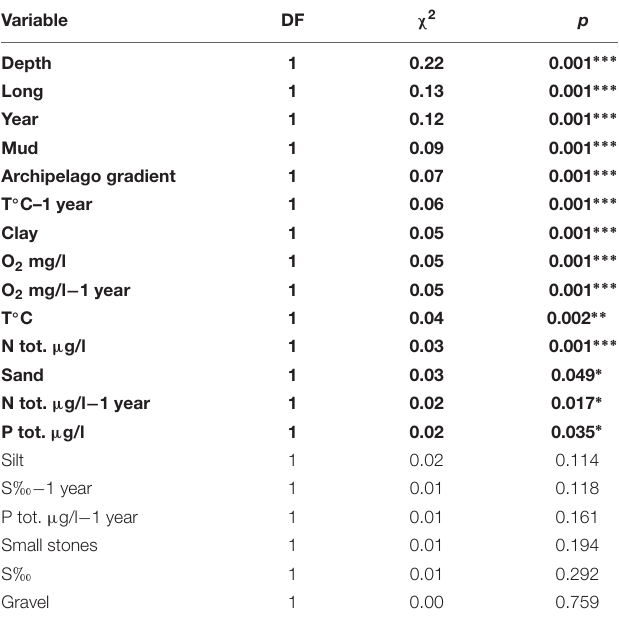
TABLE 2 | The constrained variation and the statistical significance of the environmental variables used in the CCA –analysis, when all of the 20 variables were